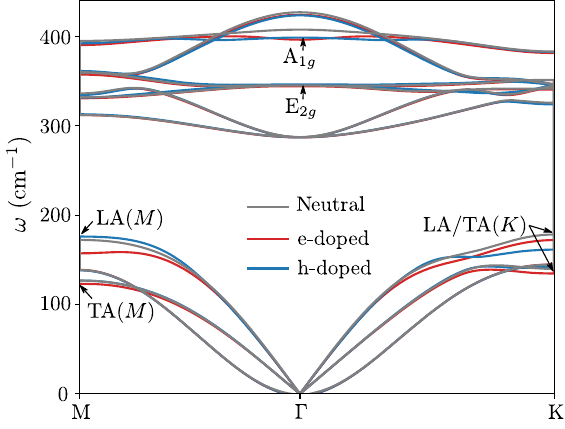
FIG. 5. Dispersion relations of the different phonons branches, calculated as described in the main text, along the high-symmetry path M- Γ -K of monolayer WS 2 . Lines of different colours correspond to either neutral (grey lines) monolayers, or monolayers under electron (blue lines), and hole (red lines) accumulation (calculations are done for 0.02 electrons or holes per unit